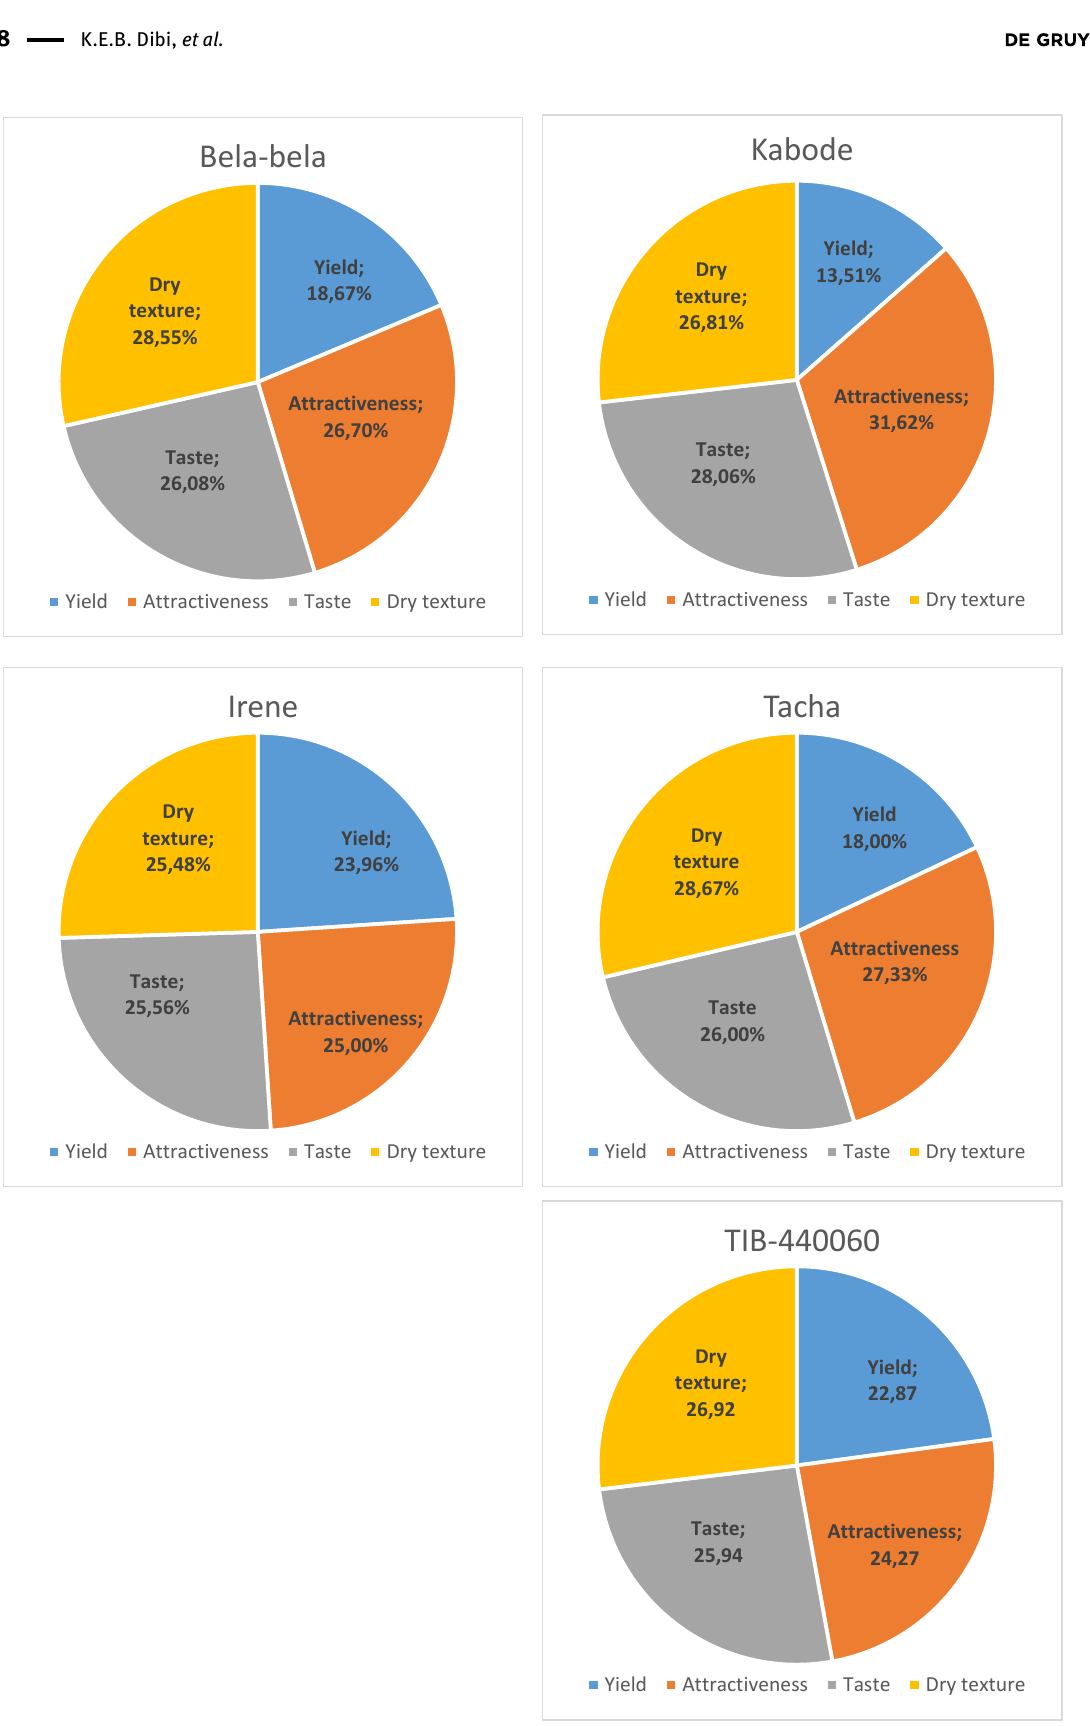
Figure 2: Characteristics of varieties according to farmer’s